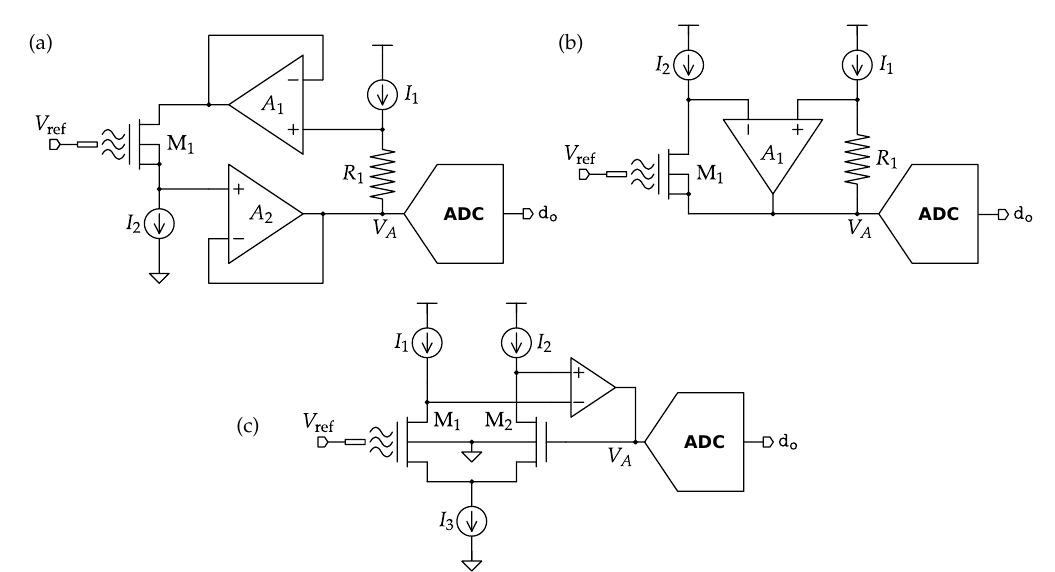
Figure 20. Potentiometric ISFET interfaces: ( a ) constant- I D constant- V DS classic dual-OpAmp and ( b ) single-OpAmp topologies, and ( c ) constant- I D OpAmp follower.